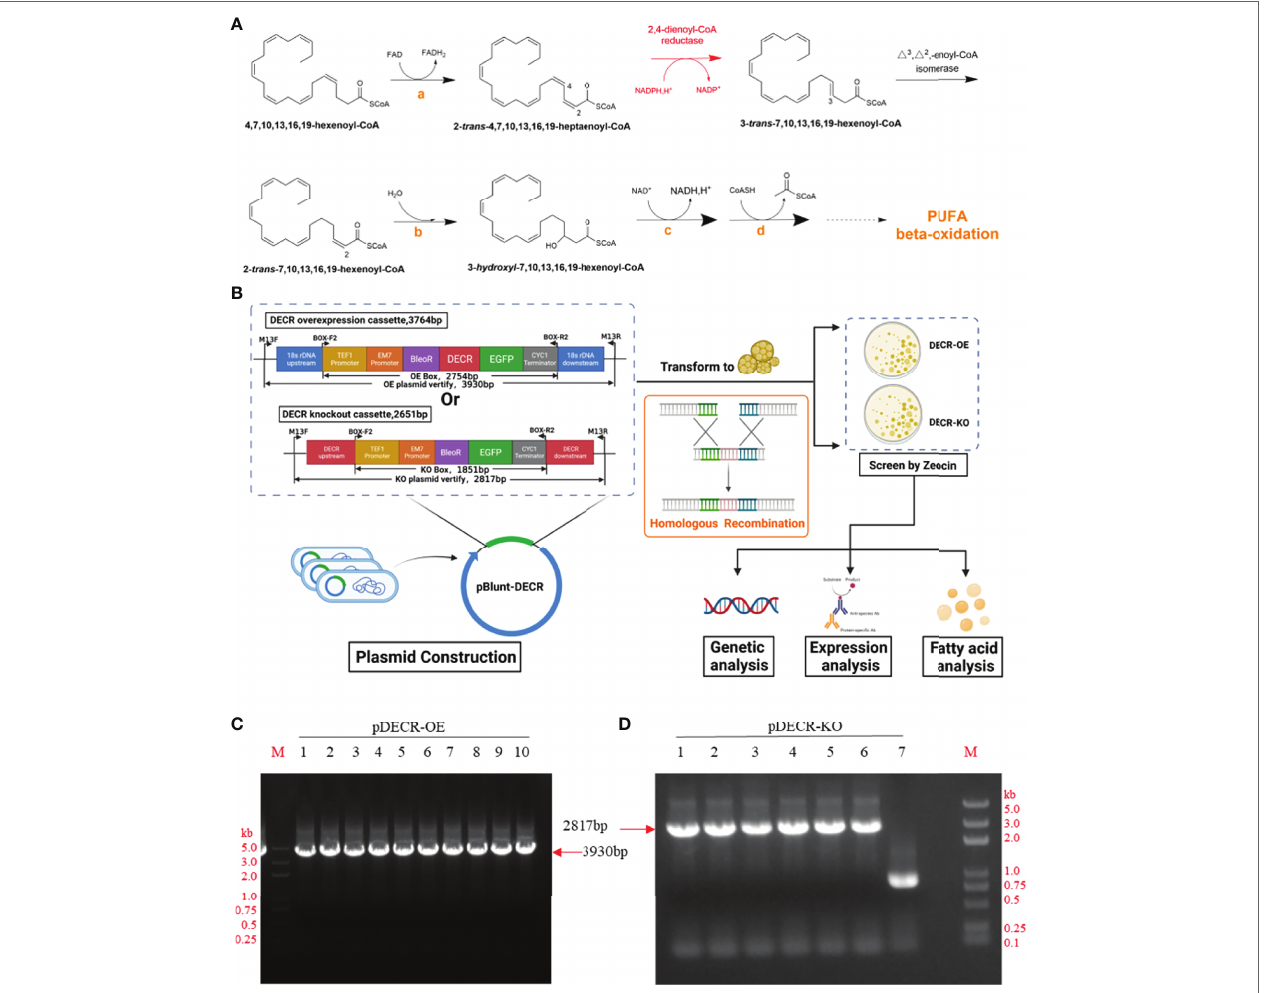
FIGURE 1 | Pathway, approach, and plasmid identification. (A) The pathway of DHA beta-oxidation. The orange letters indicate enzymes involved in standard beta-oxidation: acetyl-CoA dehydrogenase (a), enoyl-CoA hydratase (b), hydroxyacyl-CoA dehydrogenase (c), and beta-ketothiolase (d), respectively. Created with Chemdraw 20.0. (B) Approach to study the effect of DECR on fatty acids. The upstream and downstream homology arms of the overexpression (OE) cassette contain 18s rDNA, those of the knockout (KO) cassette contain DECR . After transformation, the transformants of DECR-OE and DECR-KO were screened